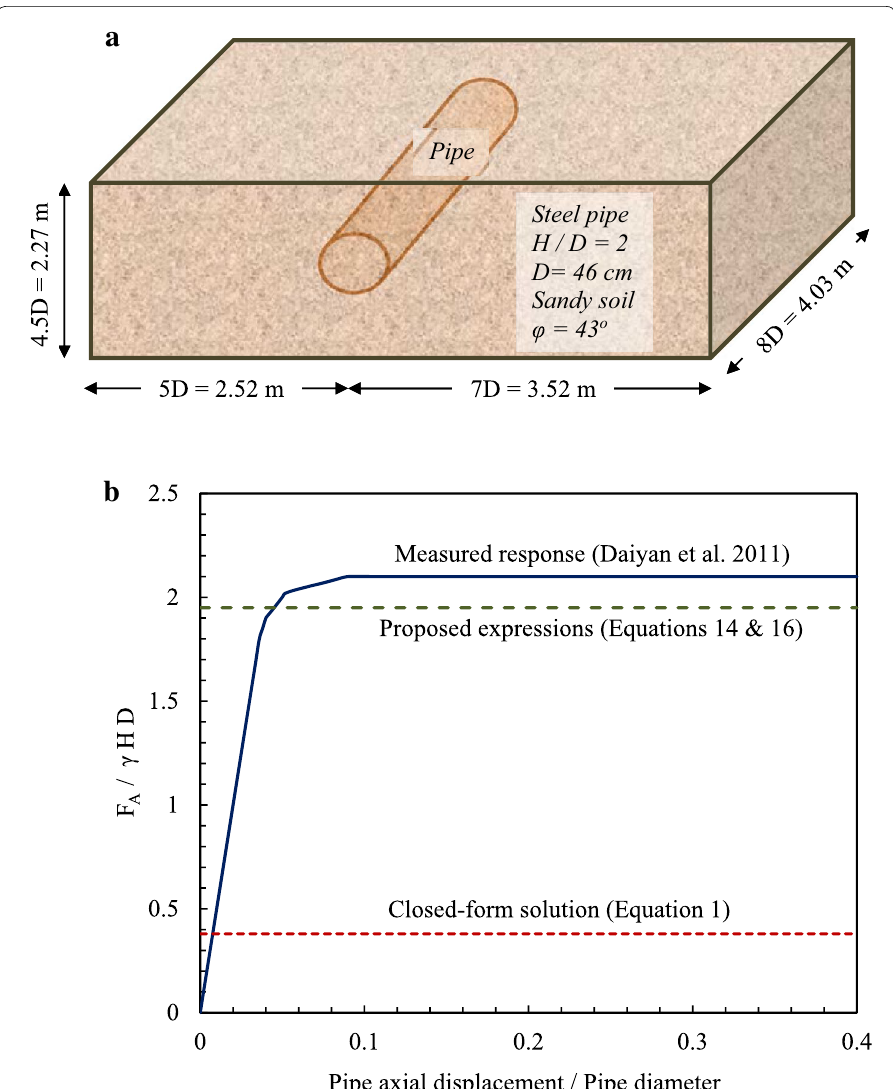
Fig. 12 Case study a Problem geometry, b comparison between calculated and measured axial interaction